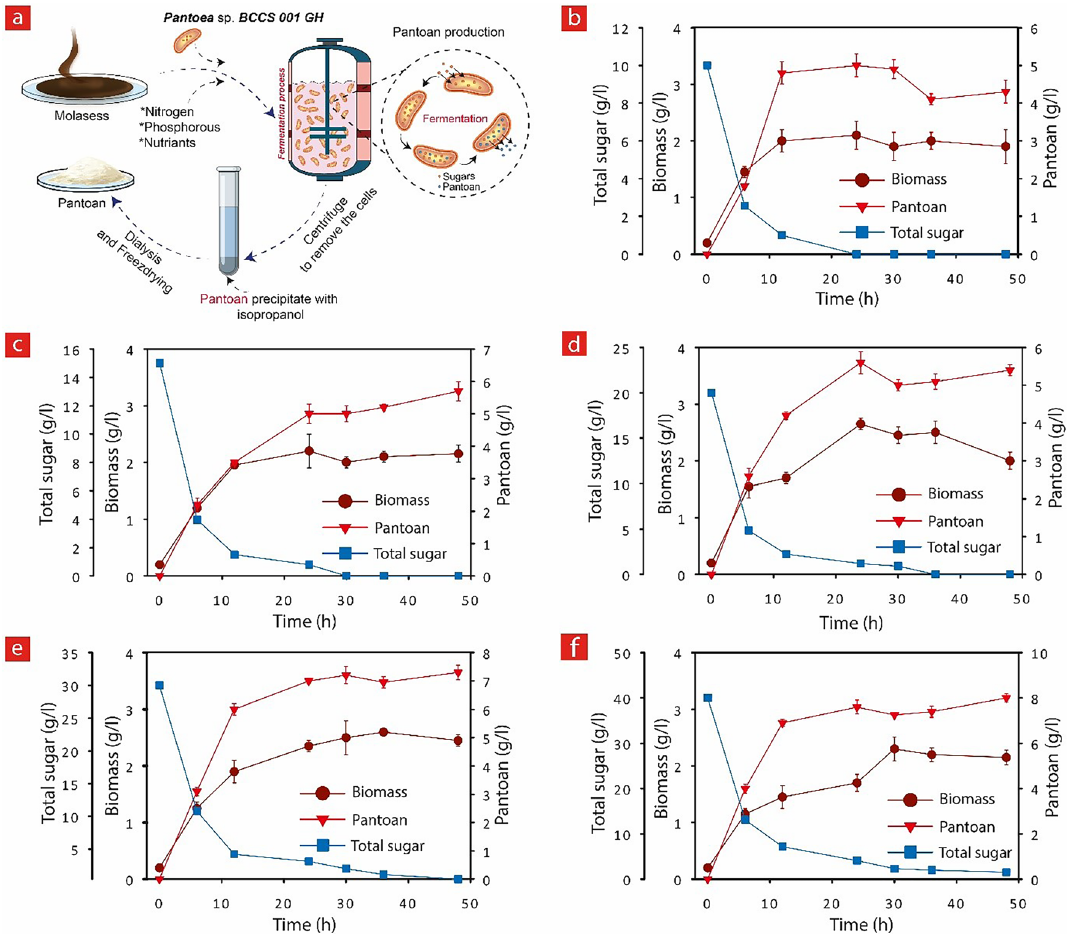
Figure 1. The effect of SBM concentration on biomass and Pantoan production using GraphPad Prism 9 (GraphPad Software, San Diego, CA). ( a ) A schematic showing the production and purification process of Pantoan. ( b – f ) Study of biomass and Pantoan production and SMB total sugre consumption (substrate consumption) at 1%, 1.5%, 2%, 3% and 4% SBM.